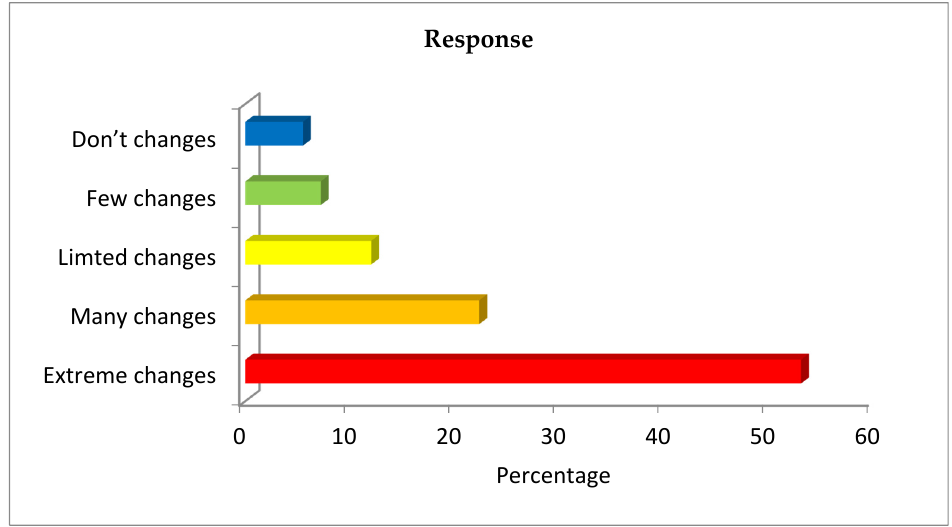
Figure 4. Farmers’ opinion of the degree of variations in climate variables in recent years.